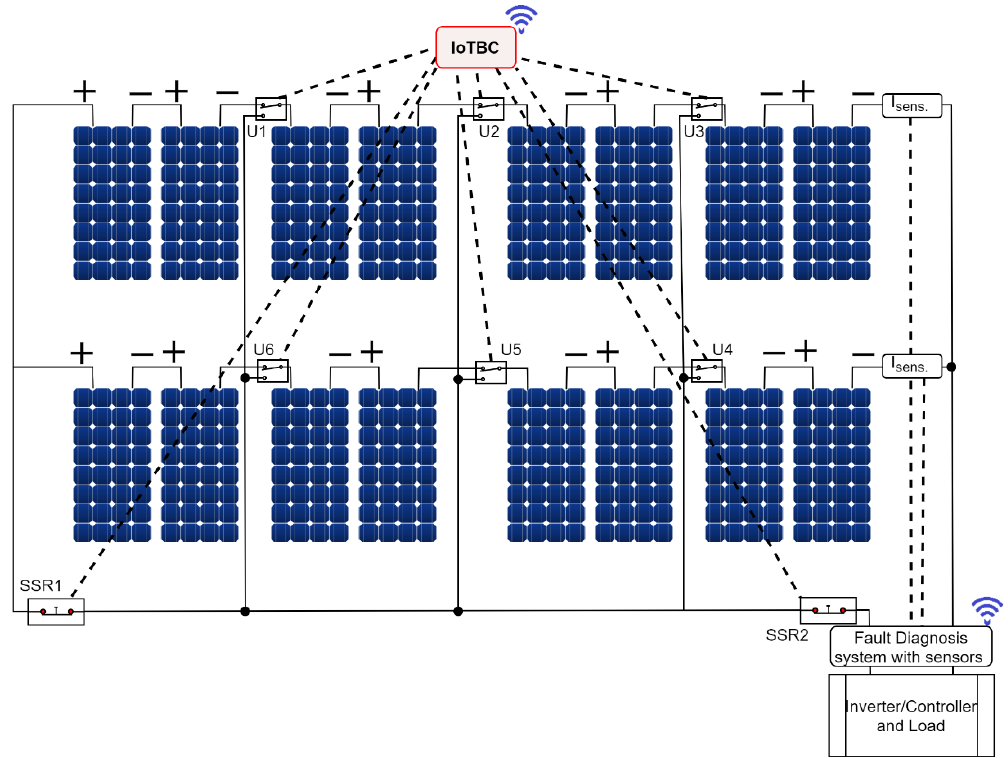
Figure 5. Two strings of eight PV panels each and an IoTBC system with a granularity level of two PV panels.